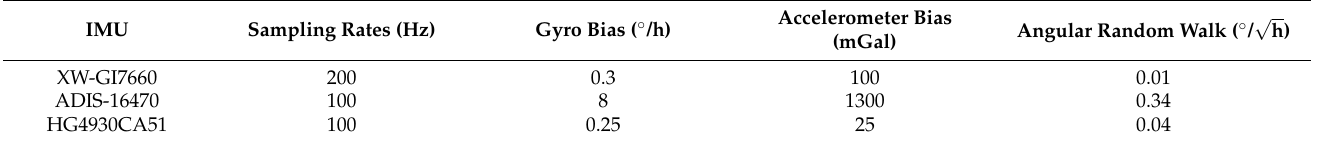
Table 1. Precision indexes of IMUs used in Wuhan and Zhengzhou vehicle-mounted